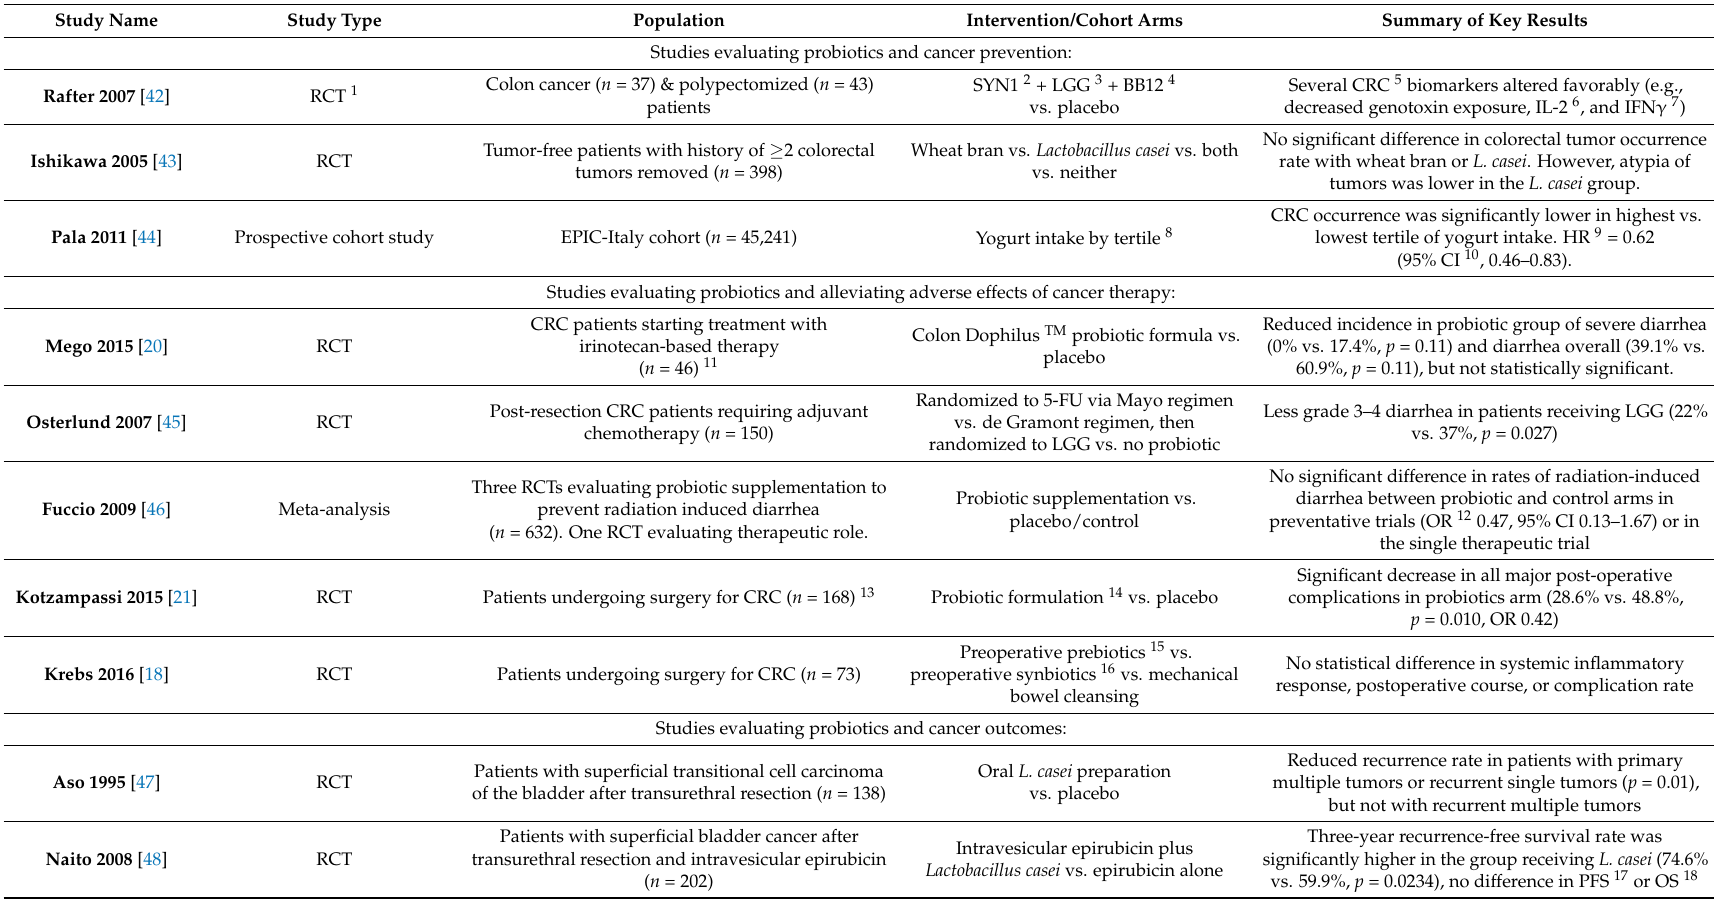
Table 1. Human studies evaluating probiotics in cancer prevention and